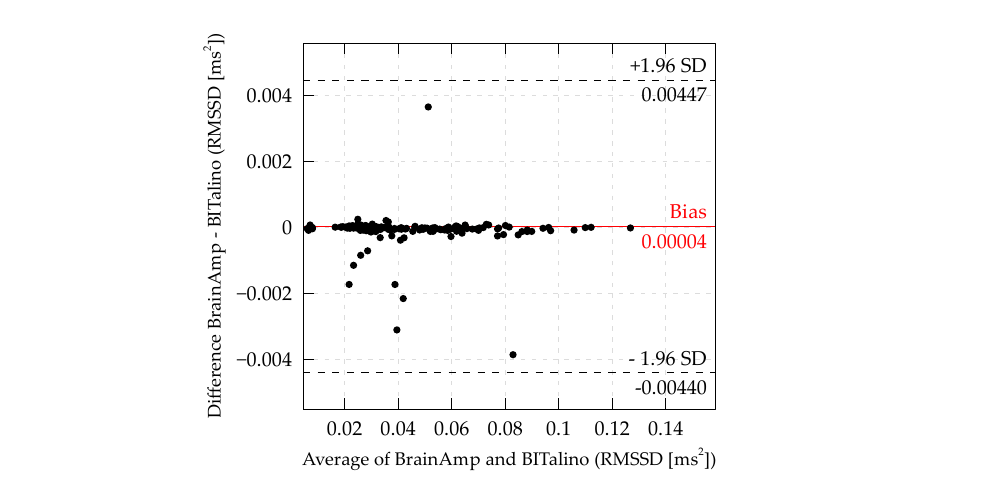
Figure 5. Bland–Altman plot of RMSSD. (Some data points outside the LoA are cutoff to offer a more detailed view of the distribution inside the LoA).